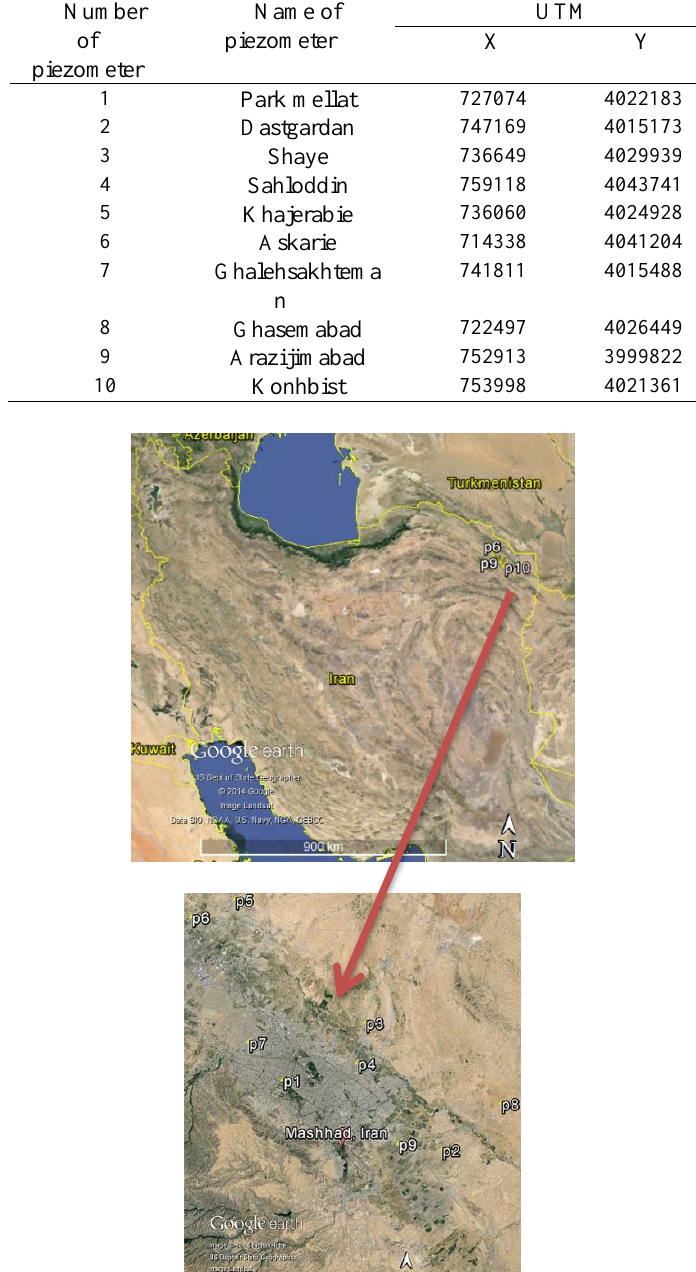
Table1 . Locations of piezometers and their features